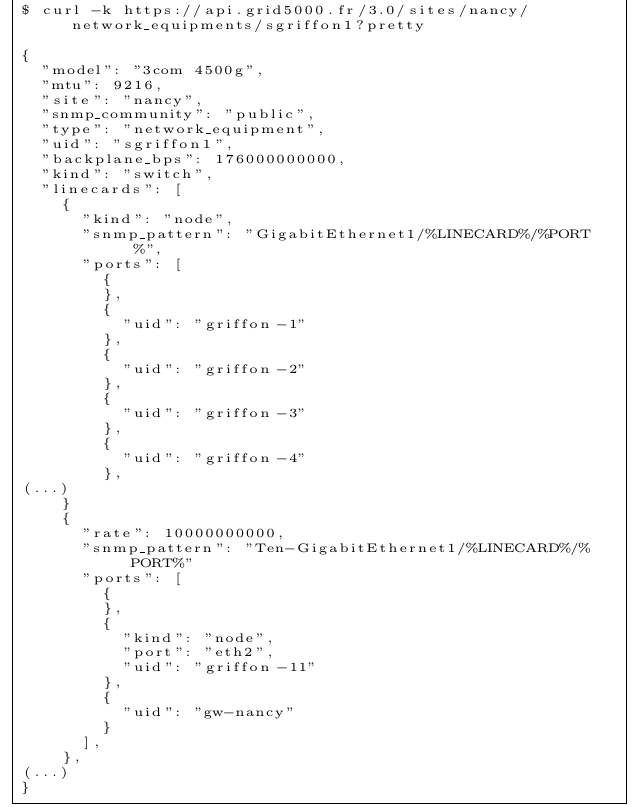
Figure 3: Description of a Networking Device in Grid’5000 Reference API